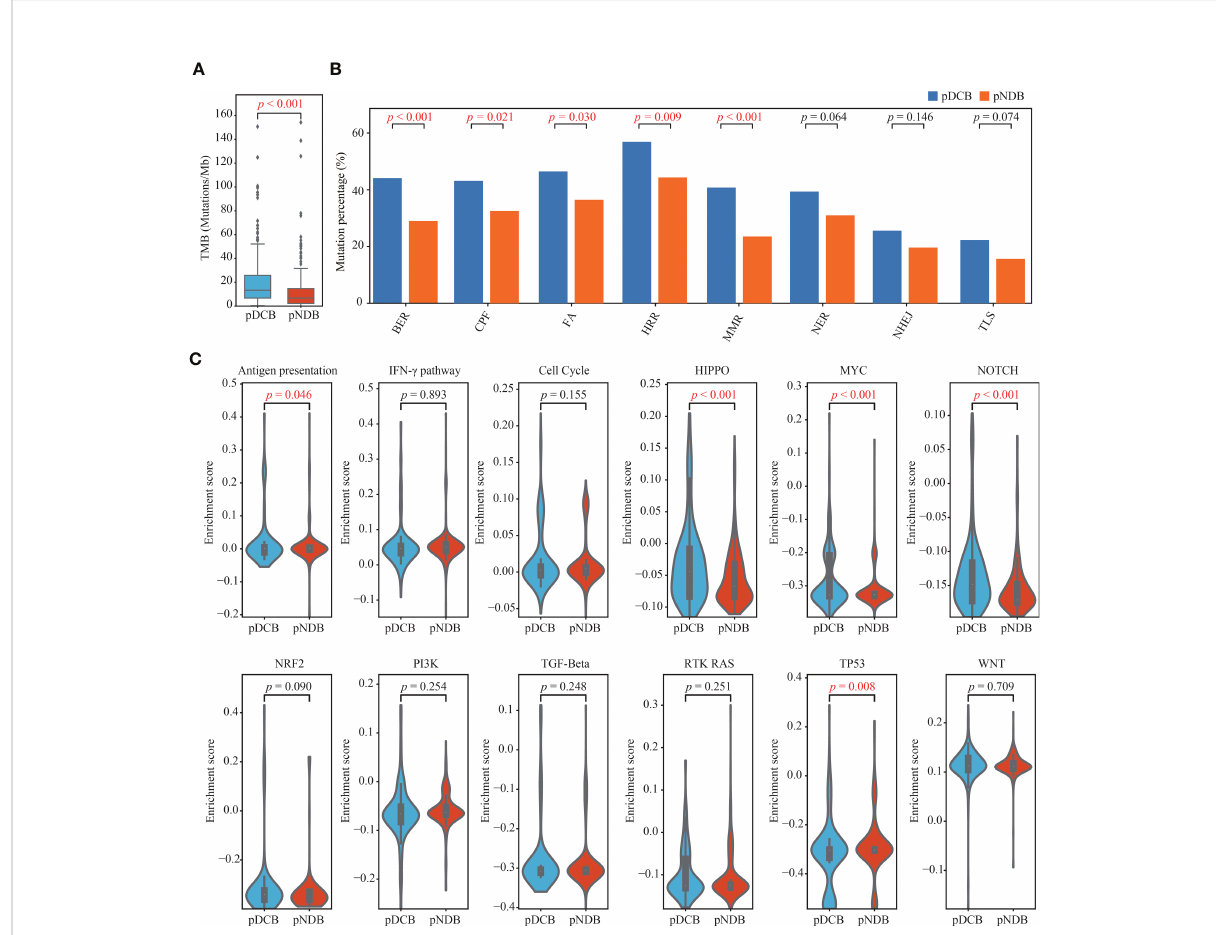
FIGURE 5 Distinctive genomic patterns associated with the DCB model. (A) Comparison of TMB between patients with pDCB and pNDB. (B) Barplots of DNA damage repair pathways mutation percentage between pDCB and pNDB. (C) Comparison of the enrichment scores from antigen presentation, IFN- g and ten oncogenic pathways between pDCB and